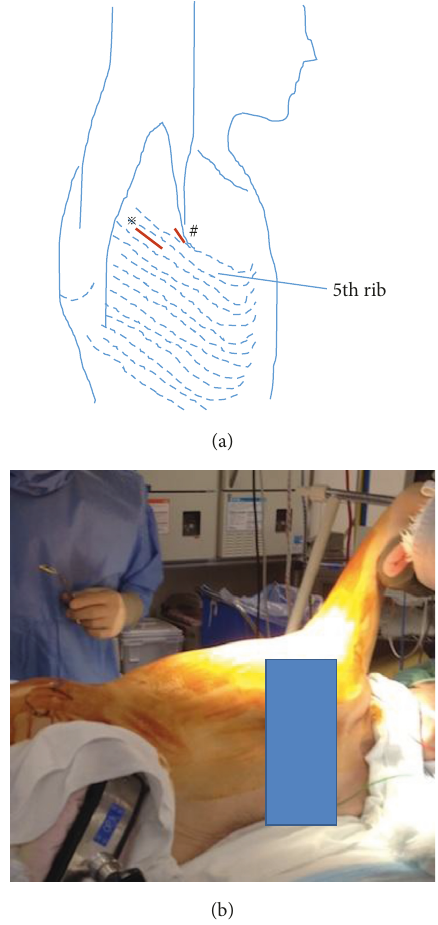
Figure 2: Schema of position and skin incisions. (a) At surgery, the patient’s arm is positioned at 80 ° of abduction and neutral flexion, extension, and rotation due to make a 4 cm long skin incision as a utility port along the mid-axillary line between the fifth and sixth costal spaces in the axillary region ( n ), which was directly located on the T5/6 disc level. One additional incision was made along the anterioraxillary line between the fourth and fifth costal spaces in the axillary region (#). (b) Left lateral decubitus position.